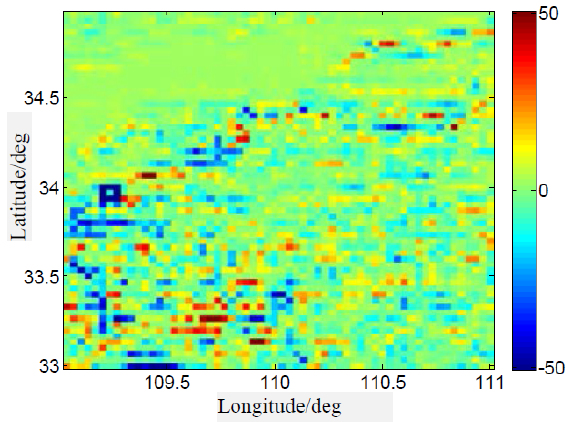
Fig. 8. difference of δg r between modified Stokes integral values and true values at altitude 500